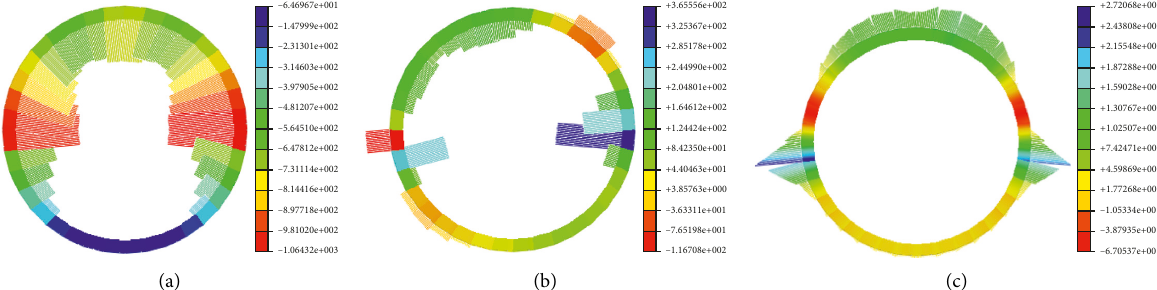
Figure 4: Internal force distribution of tunnel structure, (a) structural axial force cloud diagram, (b) structural shear force cloud diagram, and (c) structural bending moment cloud